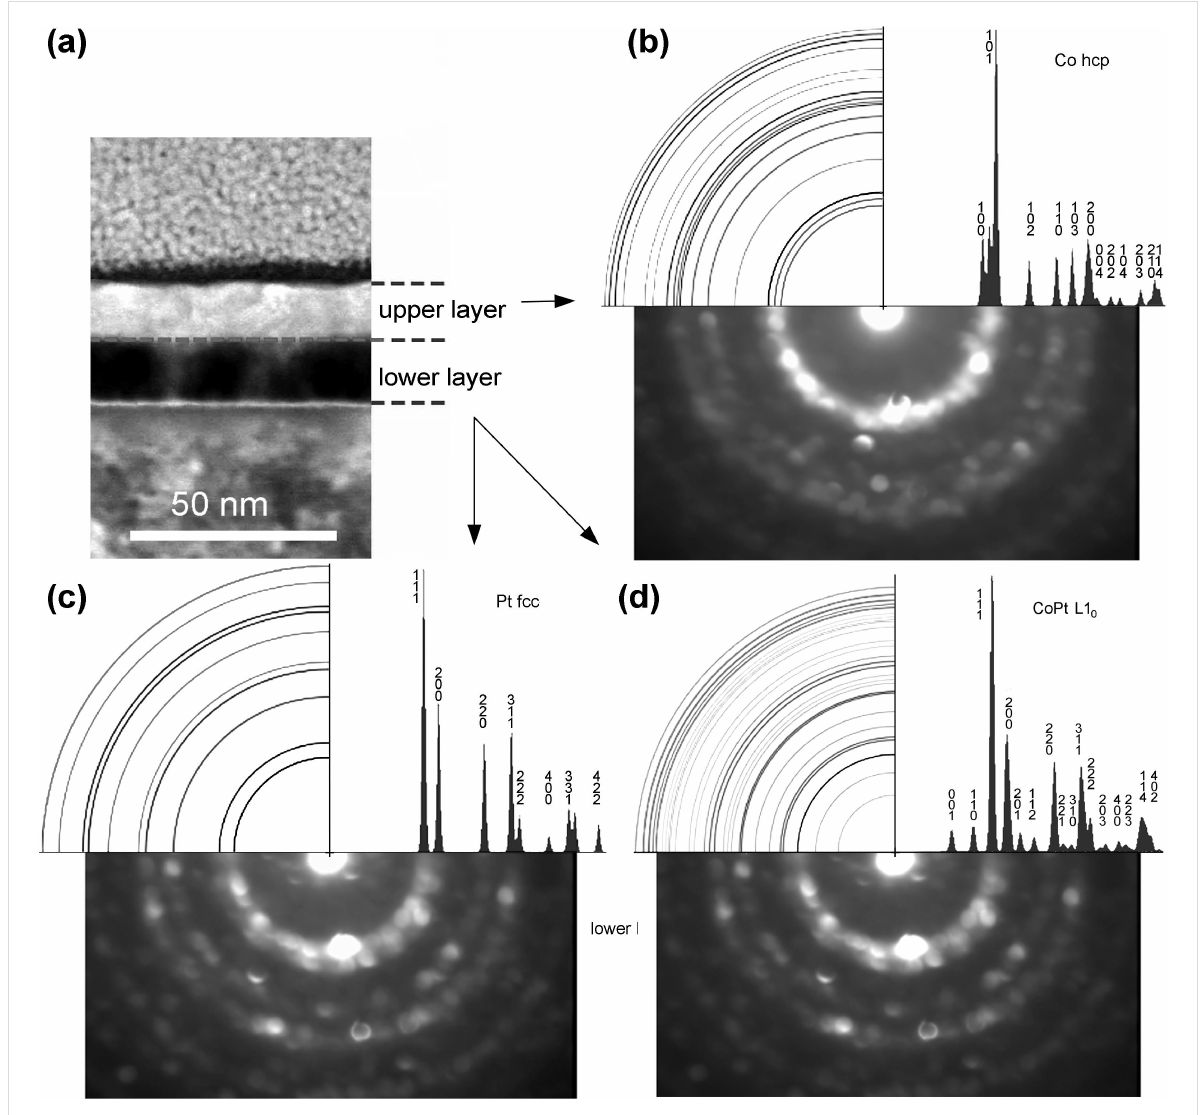
Figure 7: The location of the probed layers is shown in panel (a). Nano-diffractograms of the upper (b) and the lower (c,d) layer of sample C along- side with the simulated diffraction patterns for a Co hcp phase (b), a Pt fcc lattice (c) and a CoPt fct phase (d).